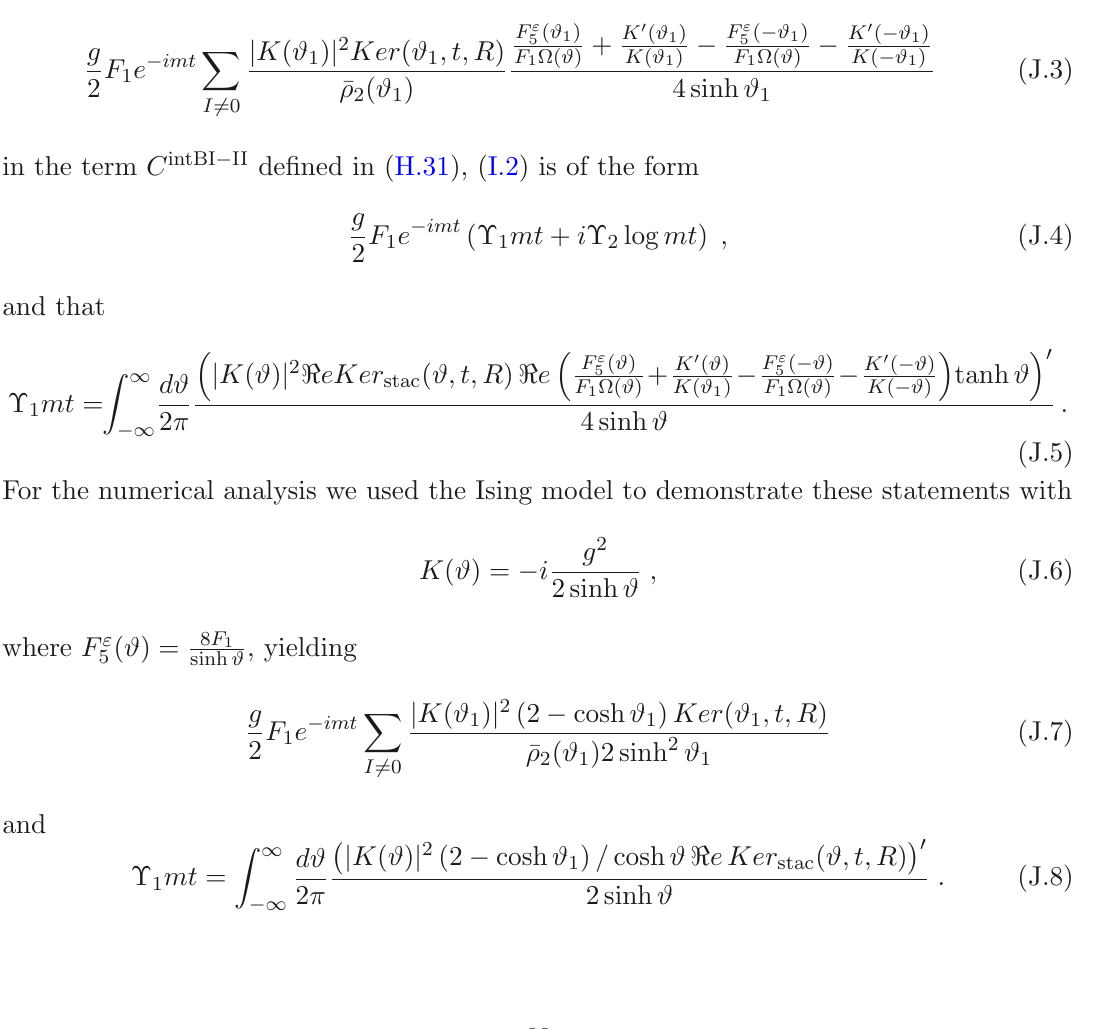
Figure 3. Modulus of differences between real and imaginary parts of e imt ˜ D 23 sizes at time instants mt = 0 , 2 . 5 , 5 , 10 and 20 for a quench in the Ising model. The purple, orange, and red dots correspond to the difference of the value obtained for 30 units of mL